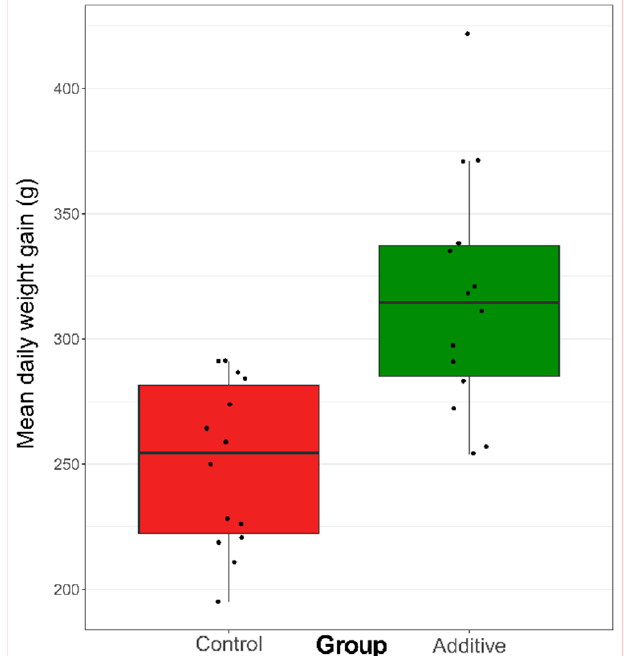
Figure 1. Box plot showing the mean daily weight gain (g) of the di ff erent lambs (black dots) that followed control (red) or additive (green) diets. The height of each box ranges from the first (Q1) to the third (Q3) quartile, which are the median values of the lower or the upper half of the mean daily weight gain (g), respectively. The horizontal black line inside each box corresponds to the median value (Q2) of the mean daily weight gain (g) of each group. Di ff erences between the mean daily weight gain (g) between control- and additive diet lambs were statistically significant ( p < 0.05).